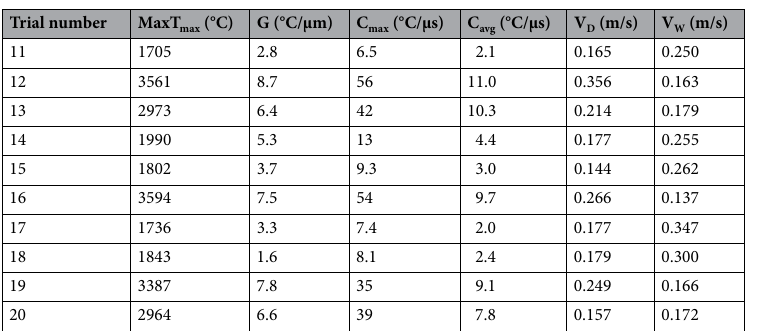
Table 2. Extracted thermal and geometrical characteristics for each trial. The thermal-related term is based on data with a spatial resolution of 30 µm and temporal resolution of 0.05 ms. The boundary velocities are calculated based on data with a spatial resolution of 2 µm and temporal resolution of 0.0143 ms. All the uncertainties are presented in "Uncertainties"